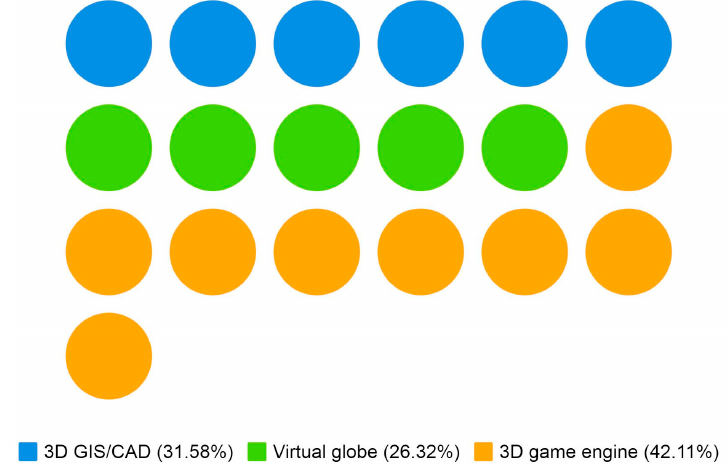
Figure 4. The division of 3D city models per platform type among the studied 19 projects.